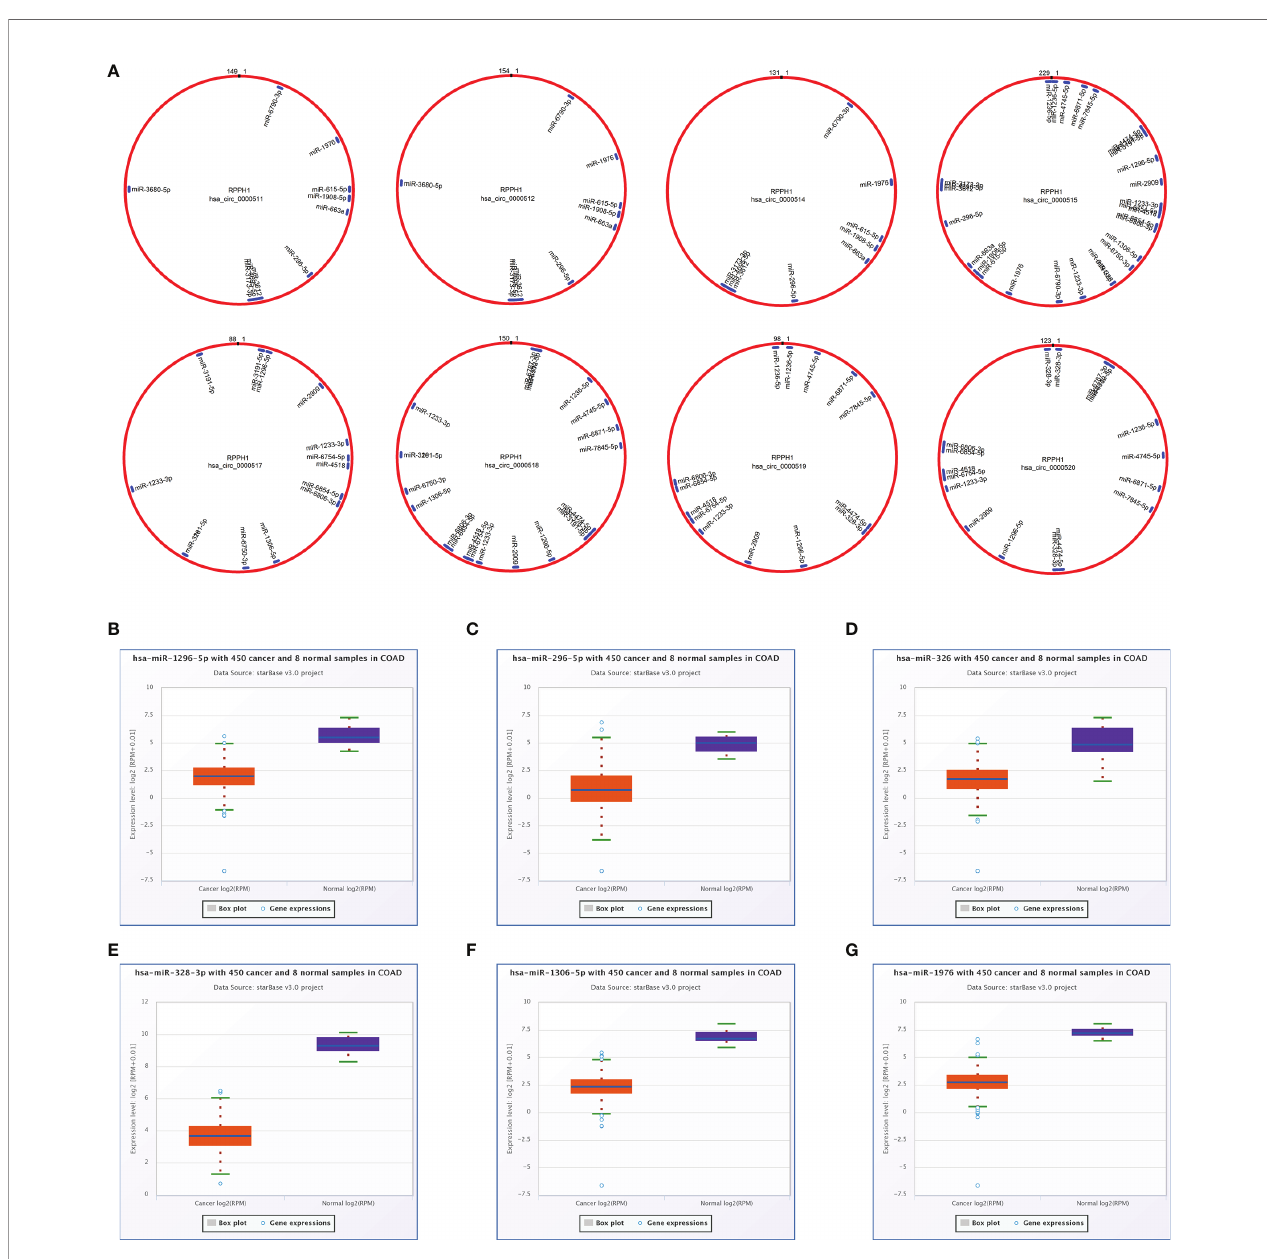
FIGURE 2 | Targeted sponge miRNA with eight circular RNAs (circRNAs). (A) The position and quantity of miRNA adsorption via circMIR1.0 software. (B – G) Six targeted sponge miRNAs with different expression levels in colorectal cancer (CRC) from starBase v2.0. (B) hsa-miR-1296-5p, (C) hsa-miR-296-5p, (D) hsa-miR- 326, (E) hsa-miR-328-3p, (F) hsa-miR-1306-5p, (G)